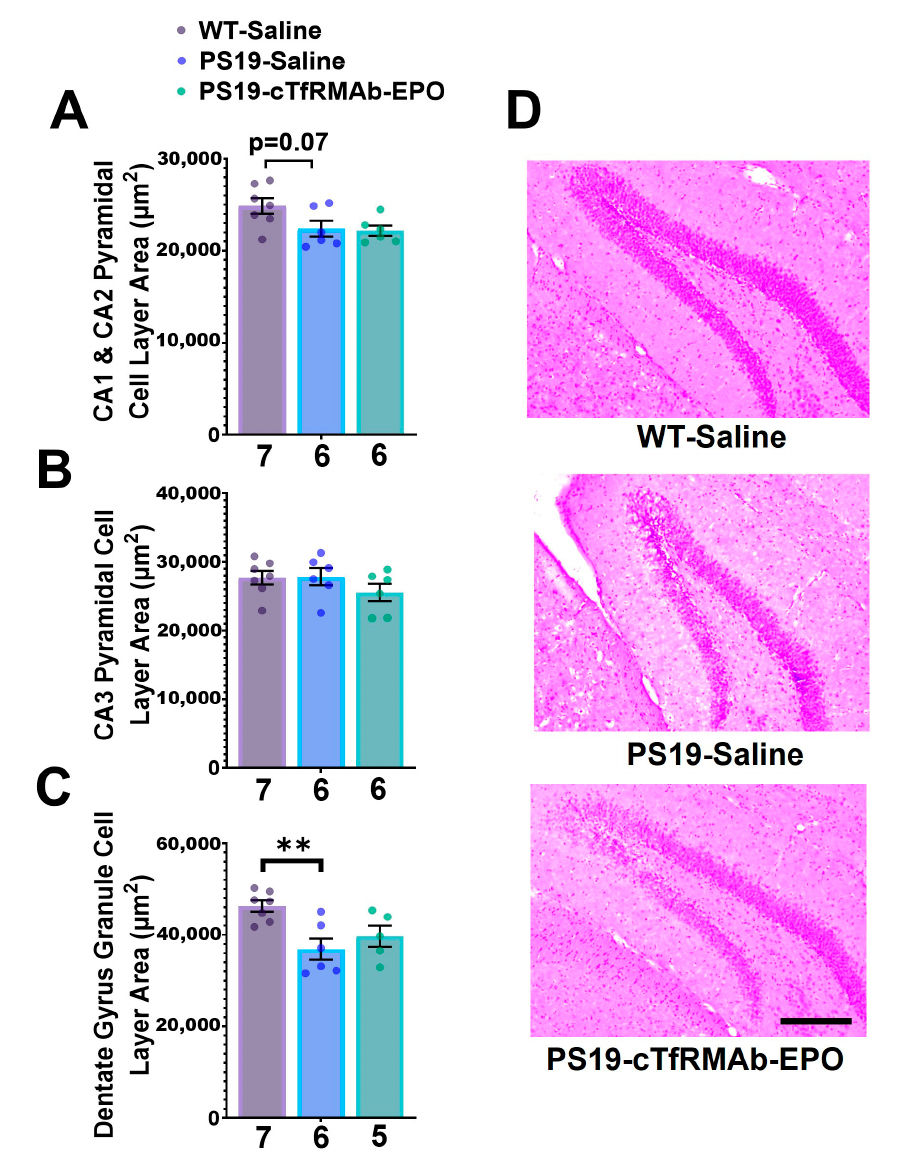
Figure 4. Effect of cTfRMAb-EPO on hippocampal pyramidal and granule cell layers with H&E Figure 4. E ff ect of cTfRMAb-EPO on hippocampal pyramidal and granule cell layers with H&E staining. ( A ) Pyramidal cell layer area in the CA1 and CA2 and ( B ) CA3, and ( C ) granule cell staining. ( A ) Pyramidal cell layer area in the CA1 and CA2, ( B ) CA3, and ( C ) dentate gyrus (DG). layer area in the dentate gyrus (DG). ( C ) The granule cell layer area was significantly higher in ( C ) The granule cell layer area was signi fi cantly higher in the saline-treated WT mice compared to the saline-treated WT mice compared to the saline-treated PS19 mice in the DG. No significant the saline-treated PS19 mice in the DG. No signi fi cant e ff ect of cTfRMAb-EPO treatment was ob- effect of cTfRMAb-EPO treatment was observed on the ( A , B ) pyramidal or ( C ) granule cell layer served on the ( A , B ) pyramidal or ( C ) granule cell layer areas compared to the PS19 saline-treated areas compared to the PS19 saline-treated mice. ( D ) Representative images of the H&E-stained mice. ( D ) Representative images of the H&E-stained hippocampal granule cell layer of the DG re- hippocampal granule cell layer of the DG region. Data are presented as mean ± SEM of n = 5–7 per gion. Data are presented as mean ± SEM of n = 5–7 per treatment group (shown below each column). treatment group (shown below each column). One outlier was excluded from the PS19-cTfRMAb- One outlier was excluded from the PS19-cTfRMAb-EPO group in panel C. One-way ANOVA with EPO group in panel C. One-way ANOVA with Holm–Sidak’s post hoc test was used to compare to the PS19-Saline mice. ** p < 0.01. Scale bar = 200 µ